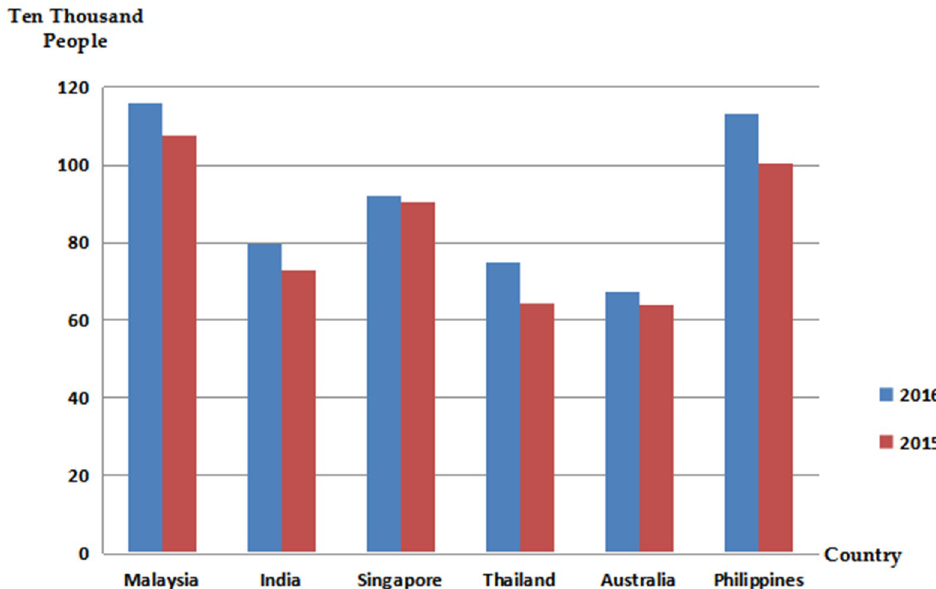
Figure 4. Statistics on the number of passengers coming to China from Southeast Asia and Australia. Note: the data comes from the Civil Aviation Administration.